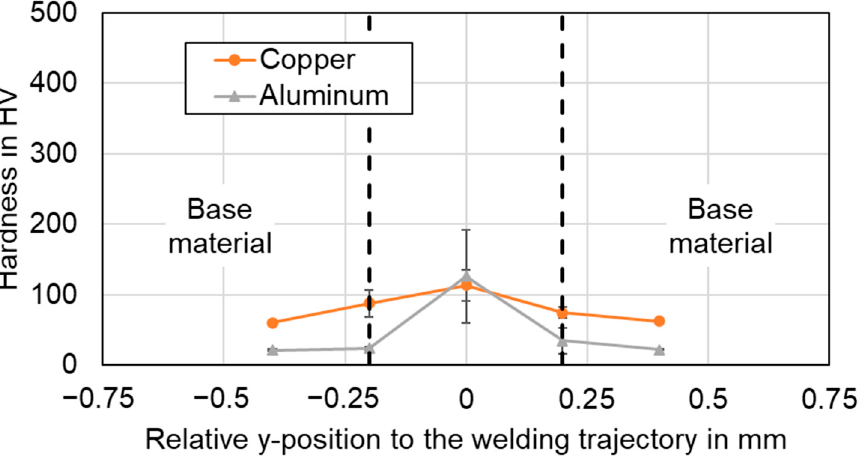
Figure 20. Microhardness profiles of the linear stitched seam fabricated with parameter set #2 ( n = 5).